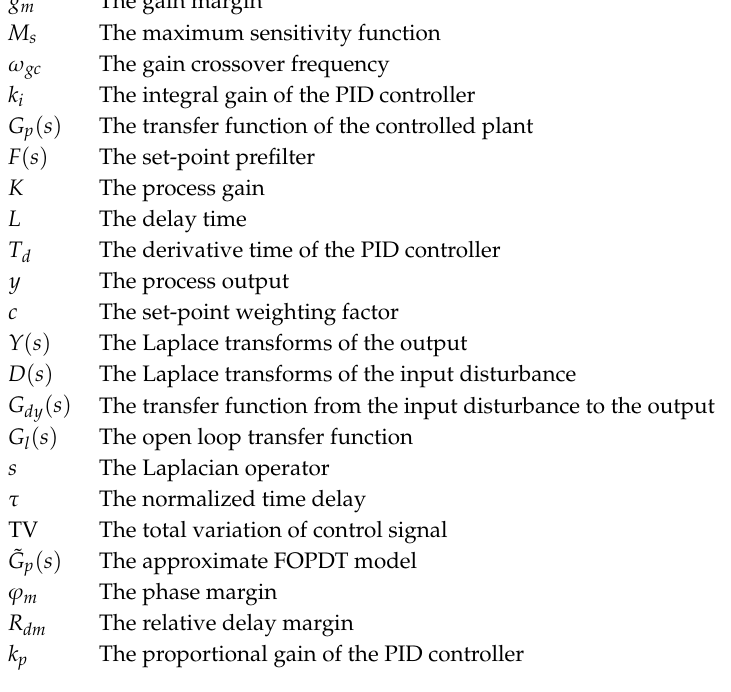
Figure S1: The distribution of k i with di ff erent k g and r dm (left: τ = 0.05; right: τ = 0.3). Table S1: The indices of the approximate FOPDT model in Equation (44) with di ff erent